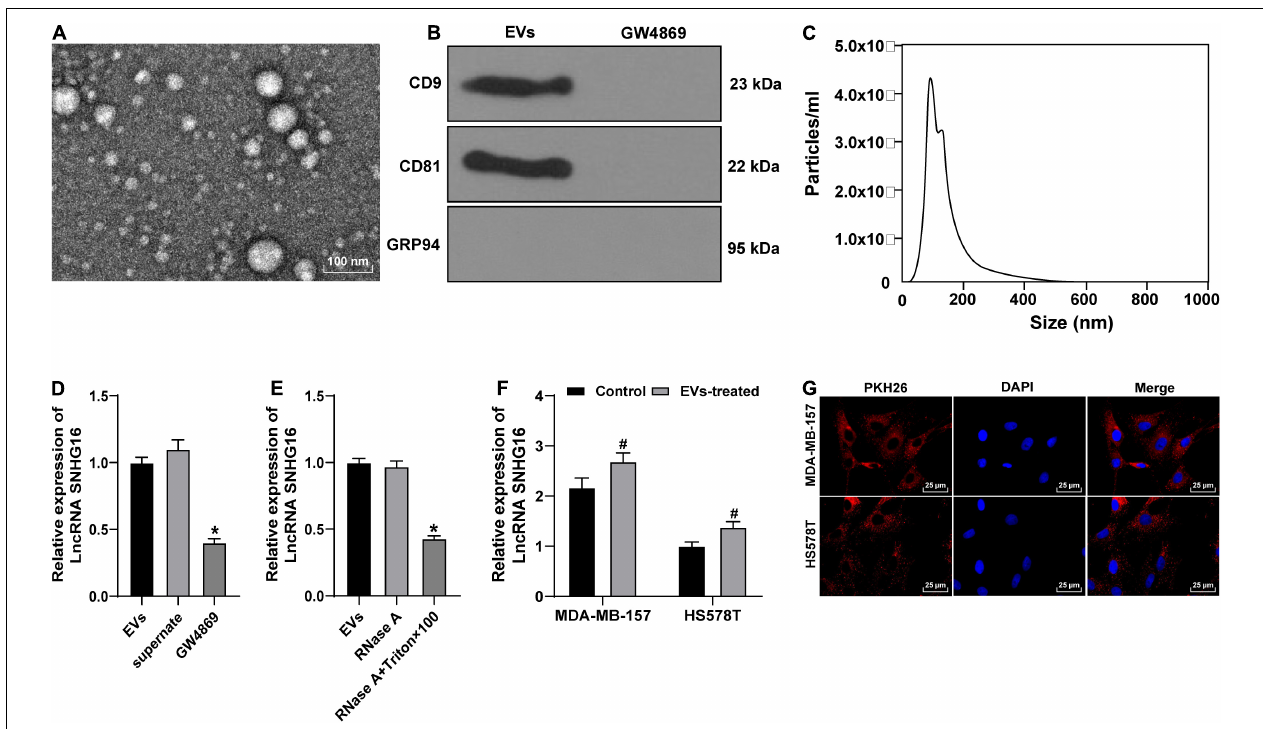
FIGURE 3 | BC cell-EVs carried lncRNA SNHG16. (A) The ultrastructure of MDA-MB-231 cell-EVs was observed under TEM. (B) The EVs markers (CD9, CD81, and GRP94) were detected using Western blotting. (C) The diameter distribution of EVs was detected using Nanoparticle tracking analysis. (D) The expression of SNHG16 in MDA-MB-231 cell-EVs, supernatant (Supernate), and GW4869-treated supernatant was detected using RT-qPCR. (E) The expression of SNHG16 in EVs treated with ribonuclease A or co-treated with Triton × 100 was detected using RT-qPCR. (F) The expression of SNHG16 in MDA-MB-157 and HS578T cells co-incubated with MDA-MB-231 cell-EVs was detected using RT-qPCR. (G) PKH26-labeled EVs were encapsulated by MDA-MB-157 and HS578T cells. Cell experiment was repeated three times. Data were presented as mean ± standard deviation. Data in D and E were analyzed using one-way ANOVA, and data in F were analyzed using two-way ANOVA, followed by Tukey’s multiple comparison test, * p < 0.05 vs. EVs group, # p < 0.05 vs. control